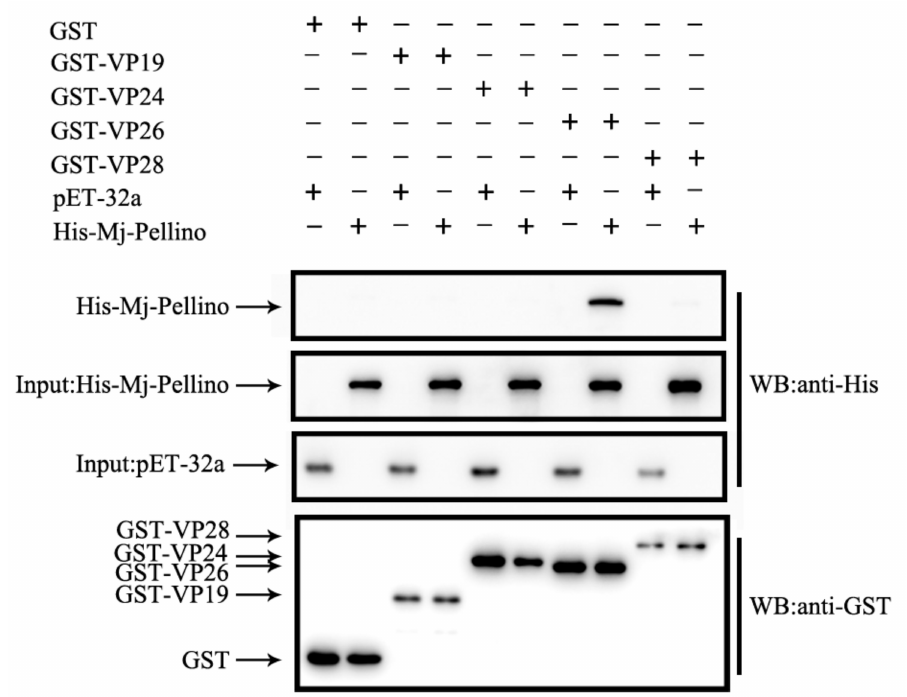
Figure 6. GST pull-down assay between MjPellino and four WSSV envelope proteins. The interaction of His-rMjPellino with GST-rVP19, GST-rVP26, and GST-rVP28 observed in the pull-down assay was confirmed by Western blotting with an anti-GST antibody. The symbol “ + ” indicates the proteins used in the GST pull-down assay.